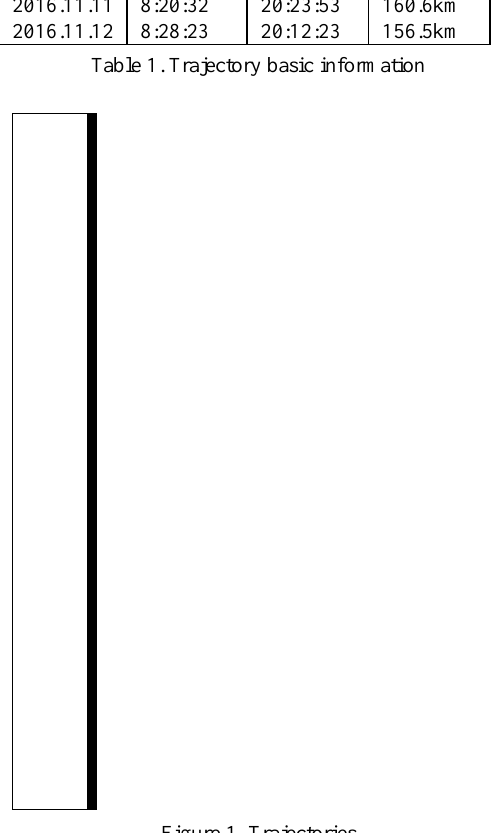
Figure 1. Trajectories